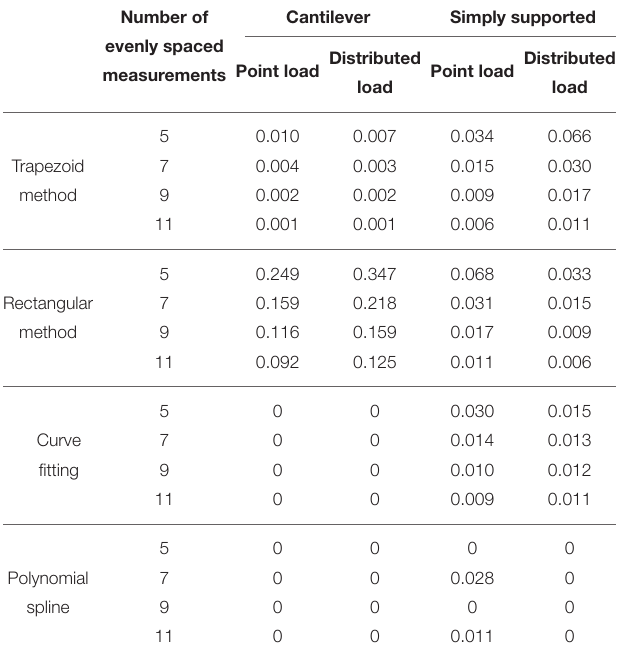
TABLE 1 | RMS for static displacement analysis with evenly spaced measurements. Number